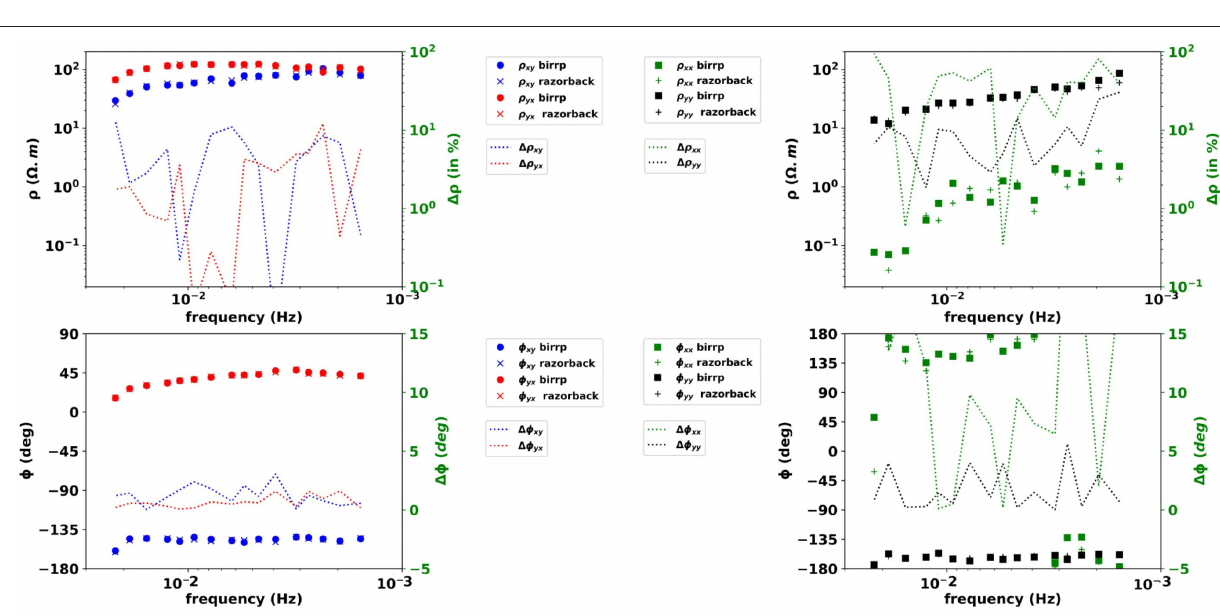
FIGURE 5 | Bounded Influence results in RR configuration. Same legend as Figure 2 but for RR